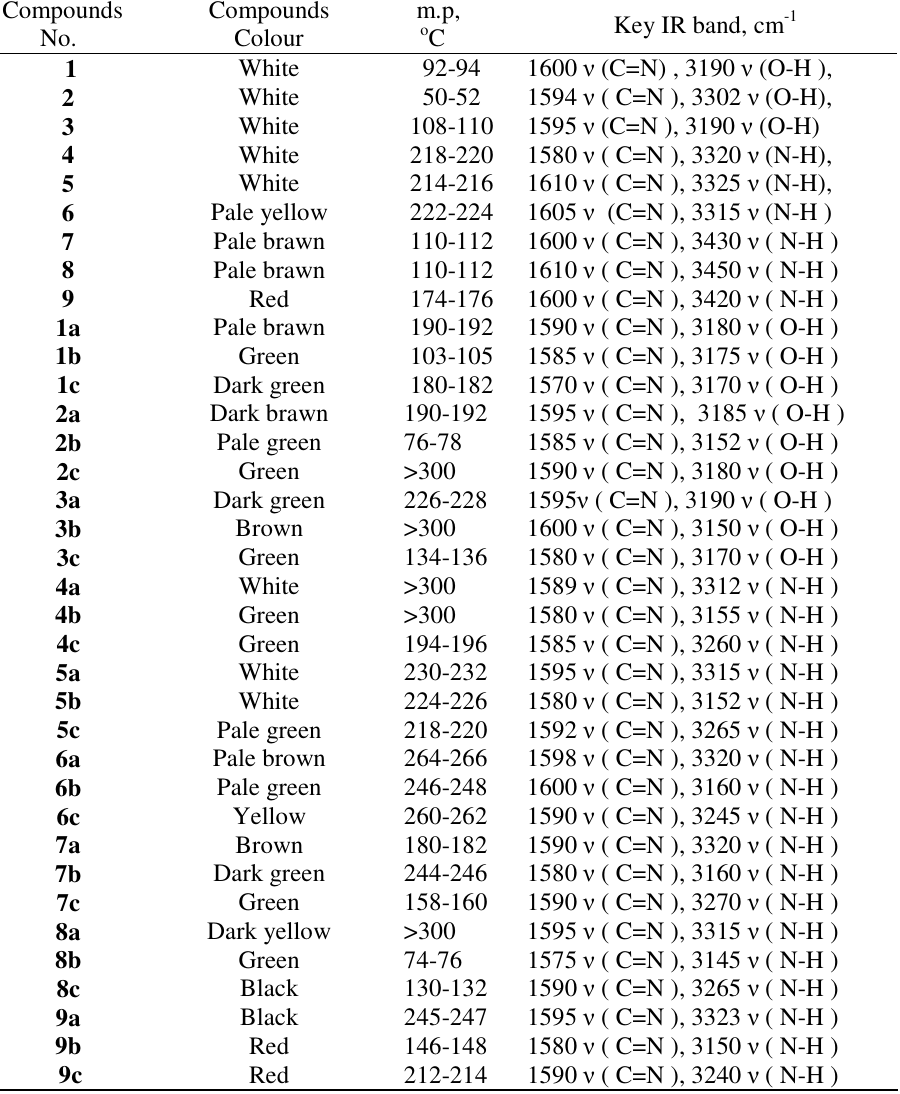
Table 1 . Analytical and spectral data of